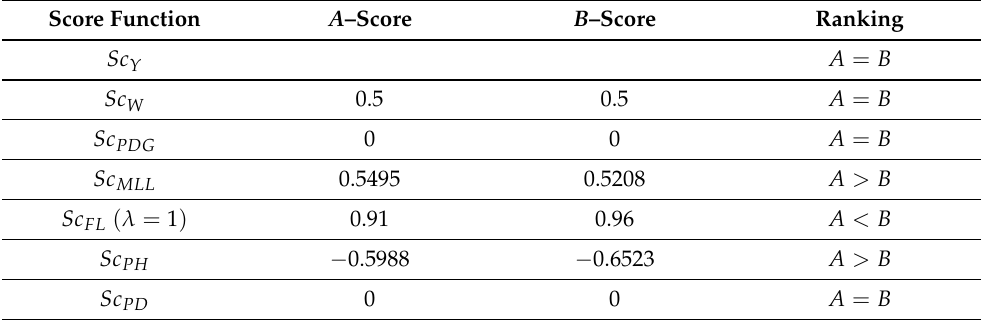
Table 2. The ranking of p − ROFS A = ( 0.3,0.3 ) and B = ( 0.2,0.2 ) with existing score functions with p = 2.